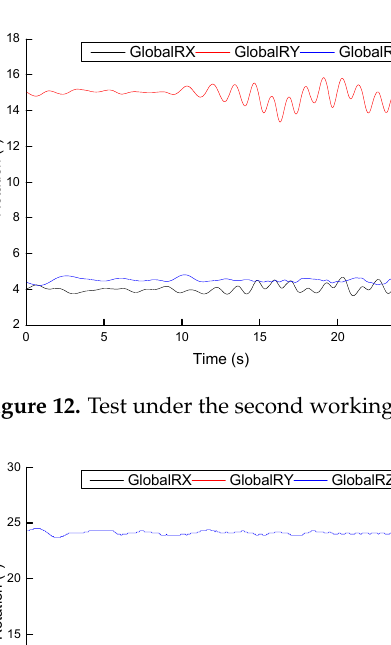
Figure 11. Test under the first working condition.